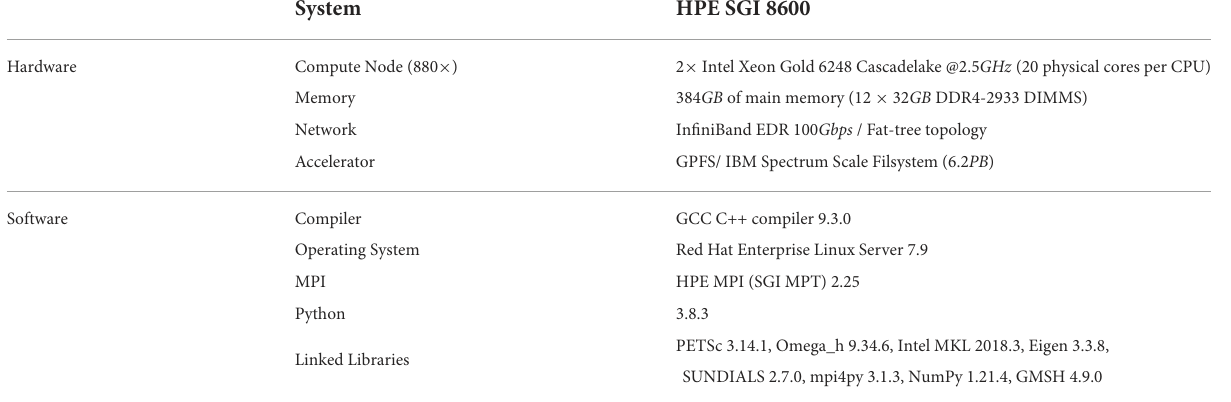
TABLE 2 Hardware and software configurations of the Blue Brain 5 (Phase 2)